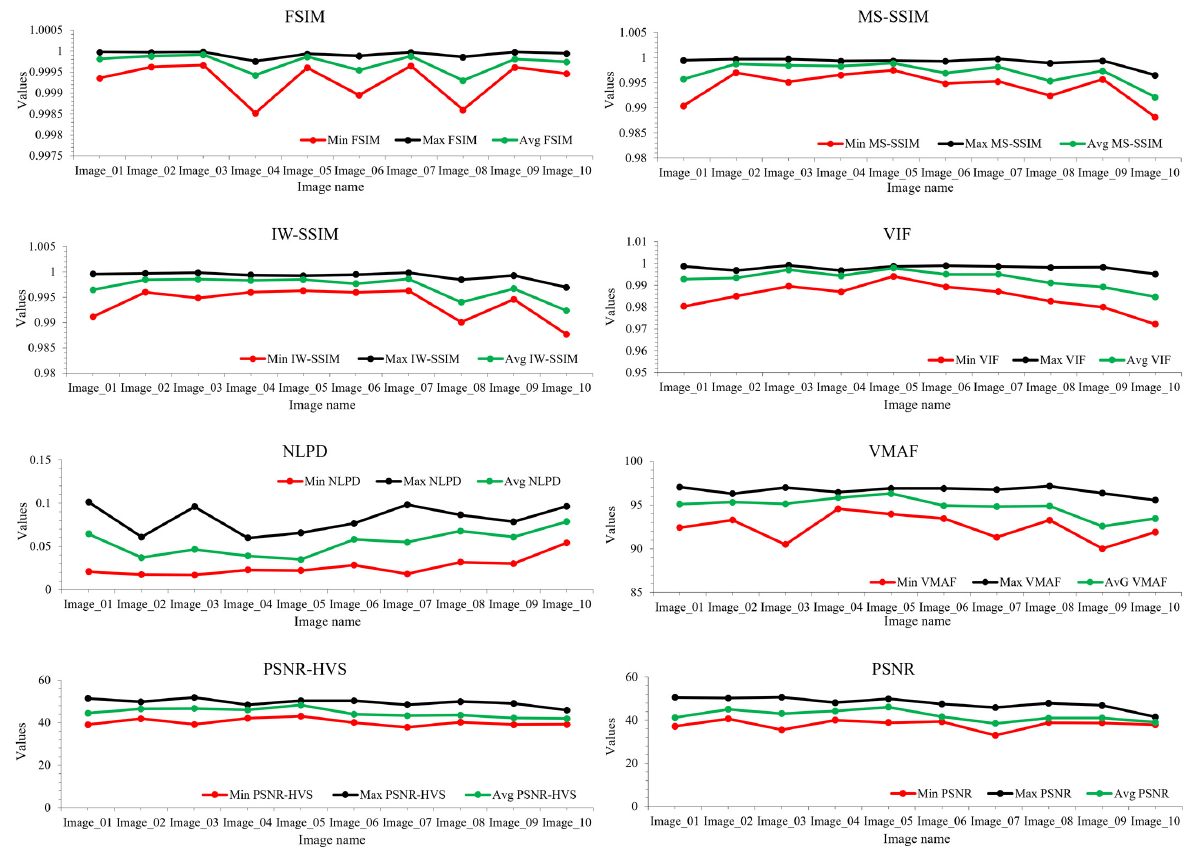
Figure 6. Representation of the line trends of the IQMs for corresponding test images at the point of visually lossless compressed level observed by subjects.